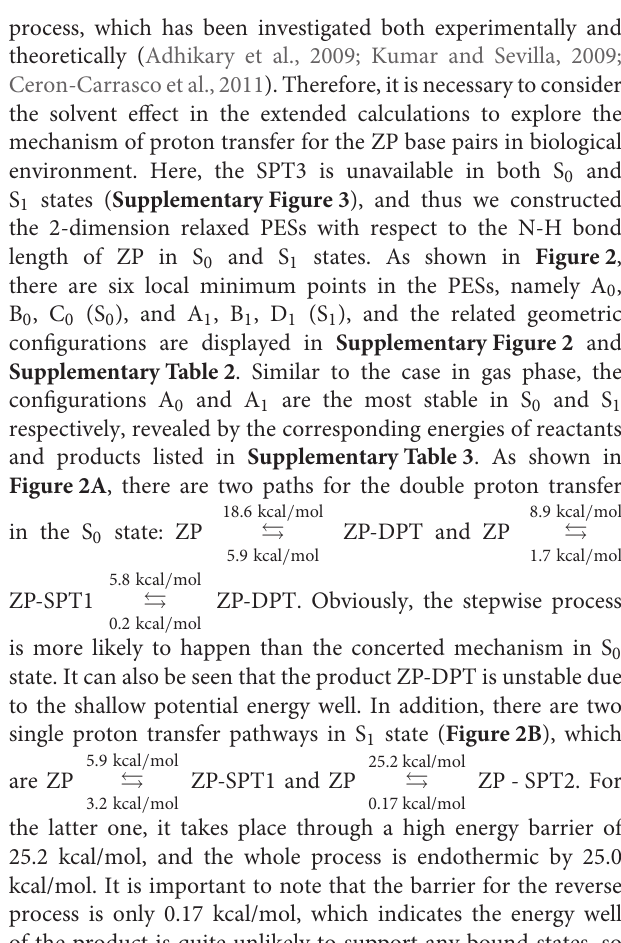
Frontiers in Chemistry |